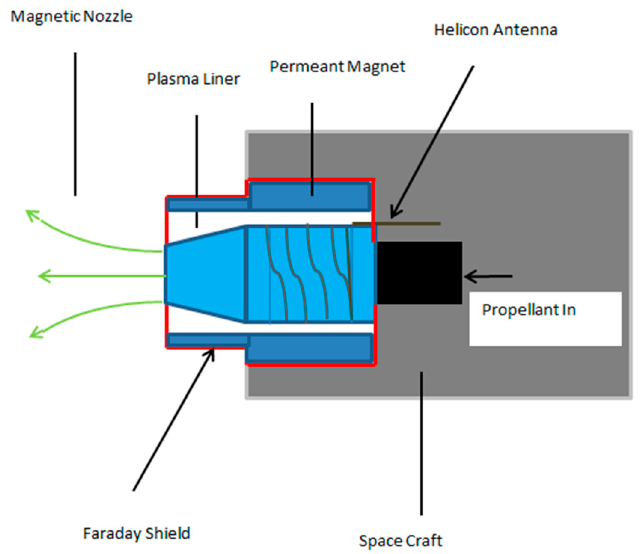
Figure 20. P4 RFT Cross Sectional Diagram [38].